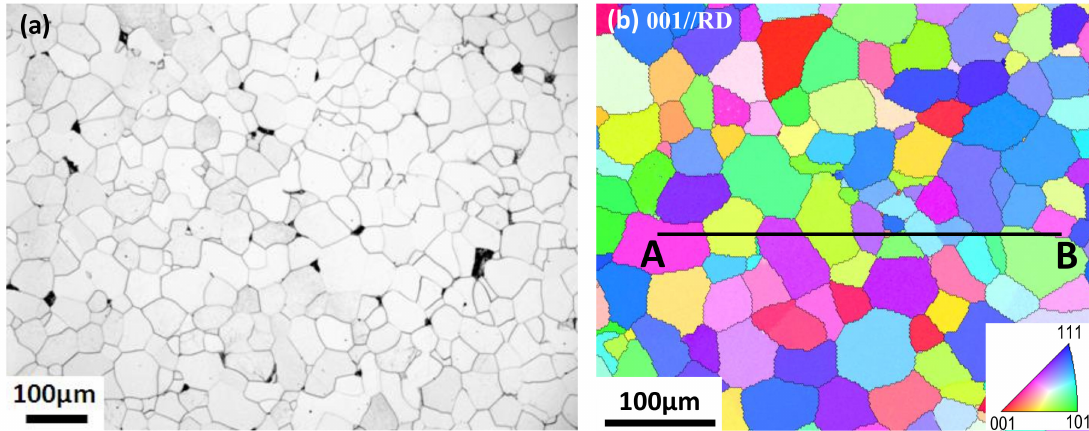
Figure 3. ( a ) Optical microstructure; ( b ) inverse pole figure (IPF) map with grain boundaries larger than 5 ◦ . Line AB is drawn which will be used in the following to show the local strain distribution.